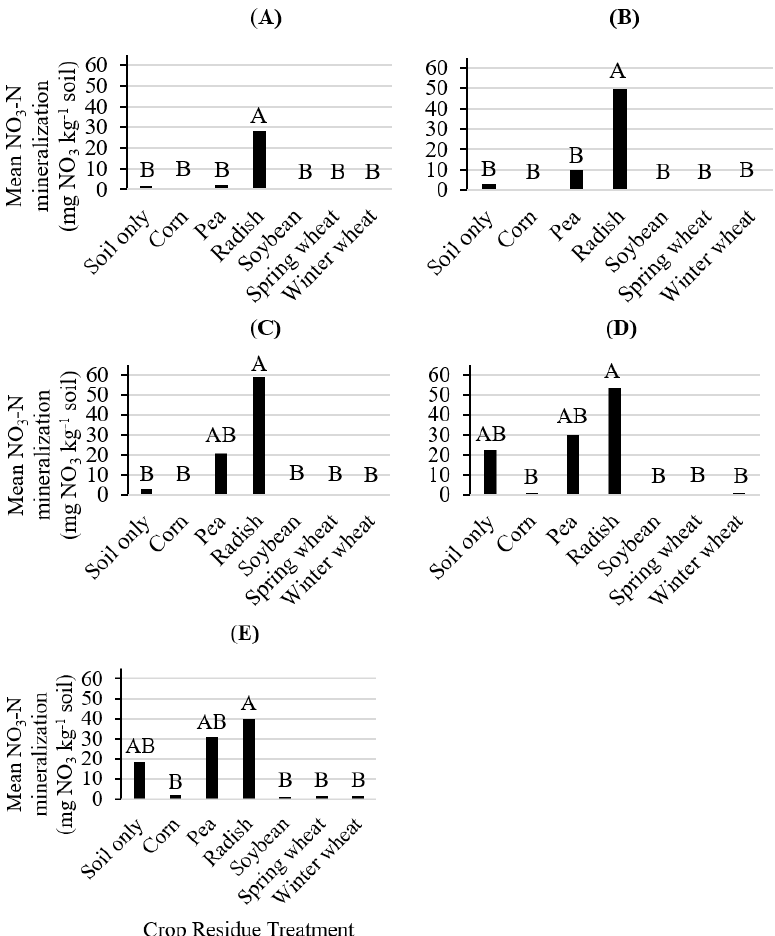
Figure 2. First incubation ( A ), second incubation ( B ), third incubation ( C ), fourth incubation ( D ), and fifth incubation ( E ) cycle mean soil NO 3 -N mineralization patterns for control, corn, pea, radish, soybean, spring wheat, and winter wheat crop residue treatments. Different letters within each graph indicate significant difference at the 0.05 level using Tukey’s comparison test.